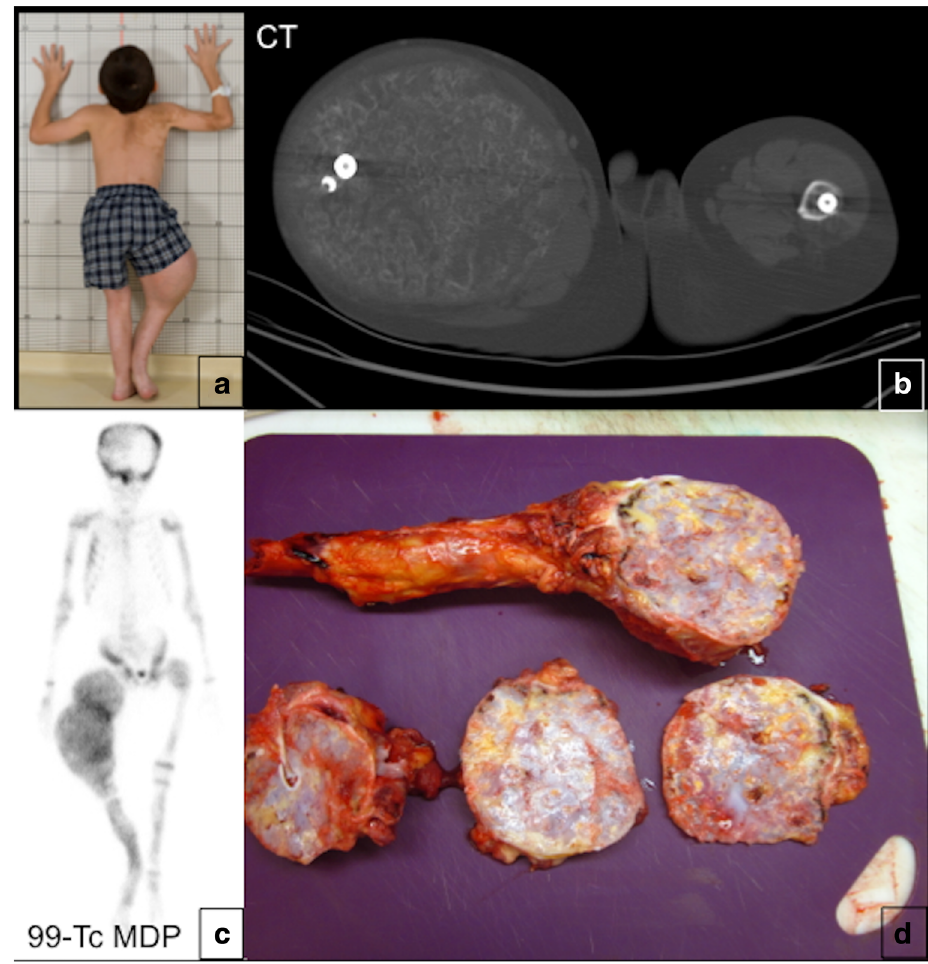
matrix transformation in fibrous dysplasia (FD). a A patient with known FD of the femurs presents with an enlarging right thigh mass. b Axial unenhanced CT of the lower extremities shows a large heterogeneous mass in the right thigh replacing femur and causing mass effect on thigh muscles. Please note a normal position of the intramedullary road in the left femur. c The mass in the right thigh shows a focal 99m-Tc MDP radiotracer uptake.